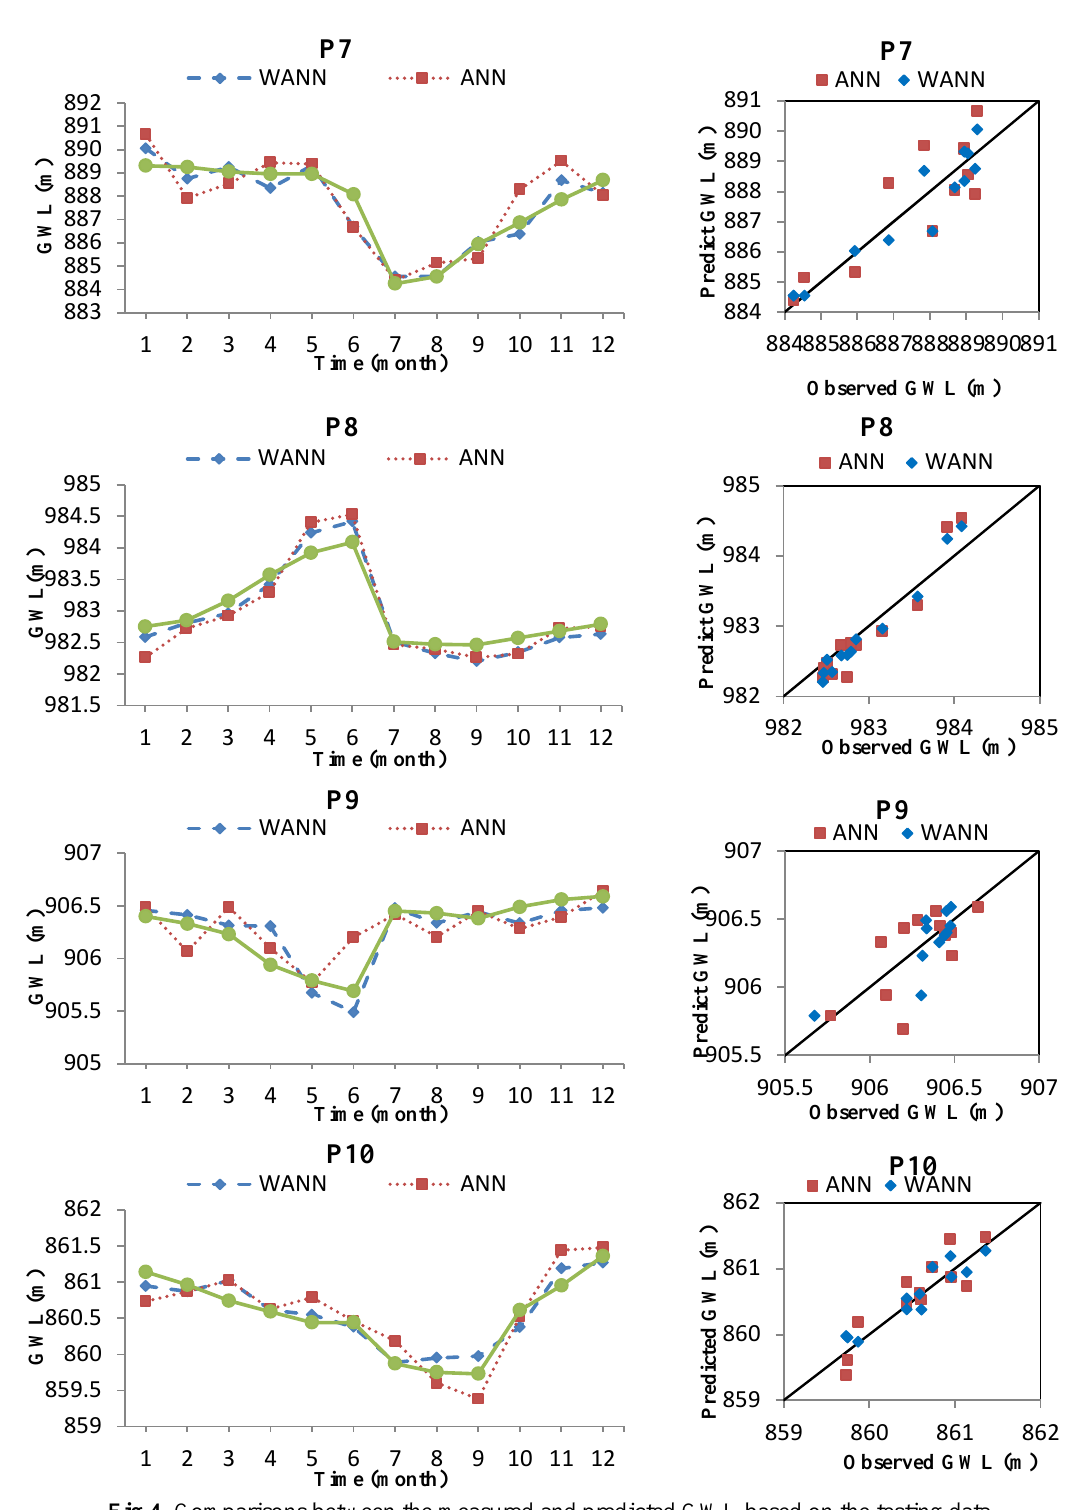
Fig 4. Comparisons between the measured and predicted GWL based on the testing